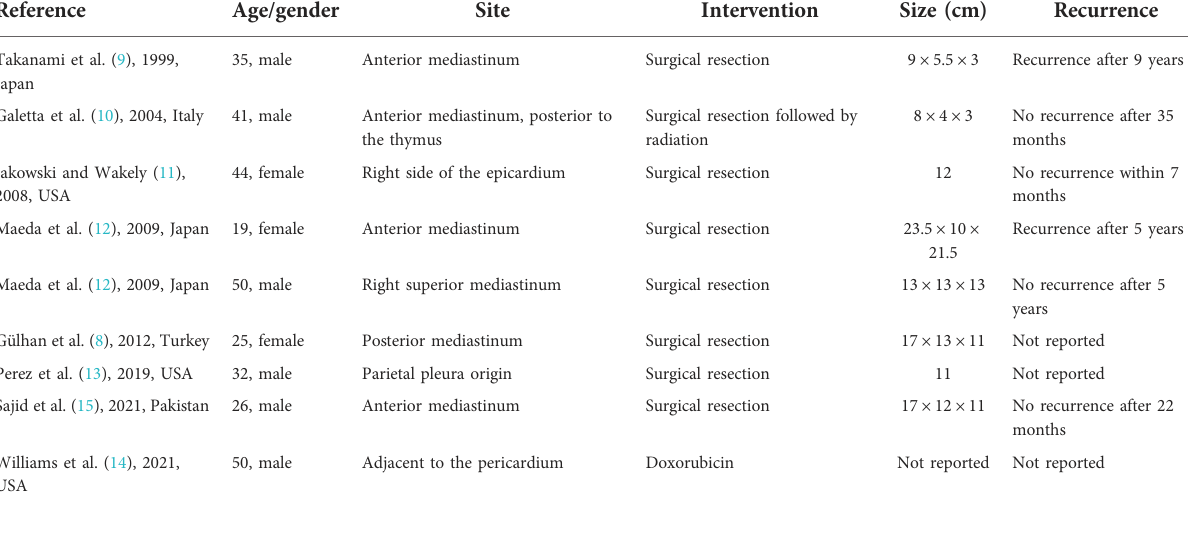
TABLE 1 Reported cases of mediastinal low-grade fi bromyxoid